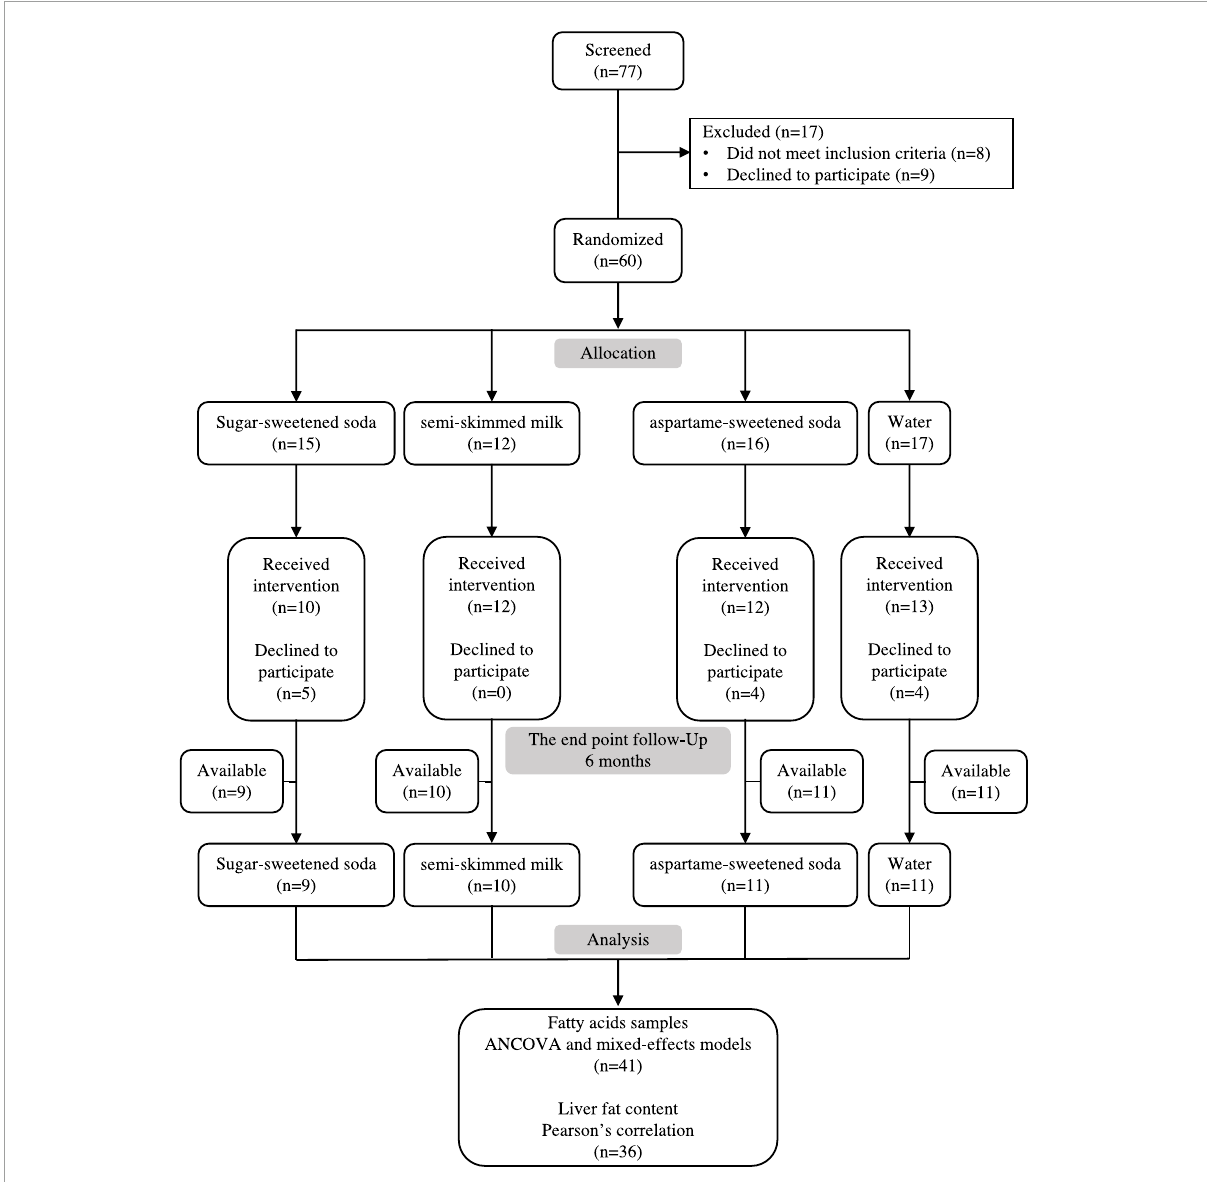
FIGURE1 The consort flow diagram. Seventy-seven subjects were screened for eligibility to enroll in the study and 60 subjects were randomized.